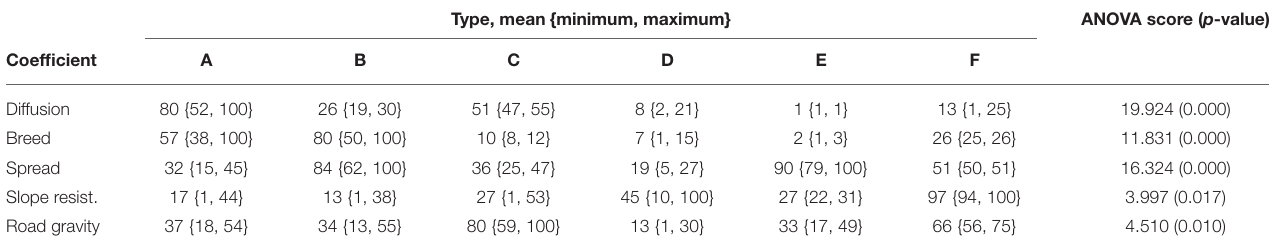
TABLE 3 | Growth coefficient statistics for each city type.